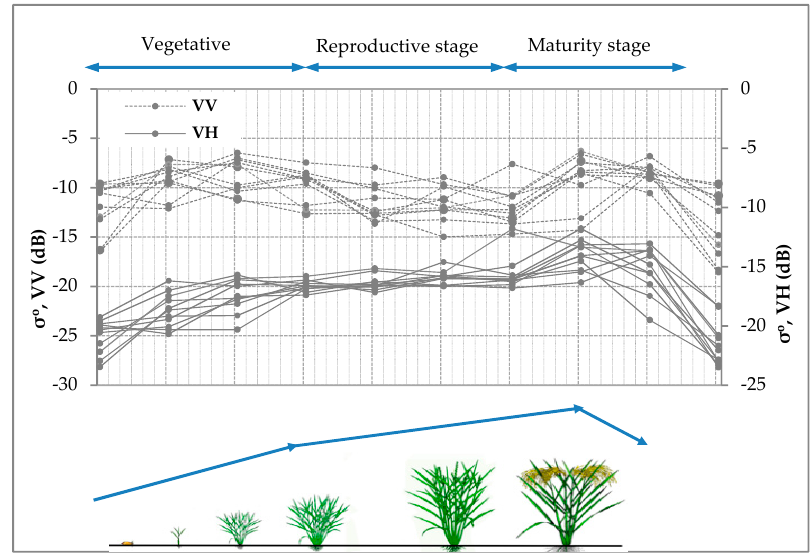
Figure 7. Growth cycle of rice in summer–autumn in the double-rice crop. The primary vertical axis is σ o VV and the secondary vertical axis is σ o VH. Growth cycle of a rice plant was collected from the International Rice Research Institute (IRRI) [68].